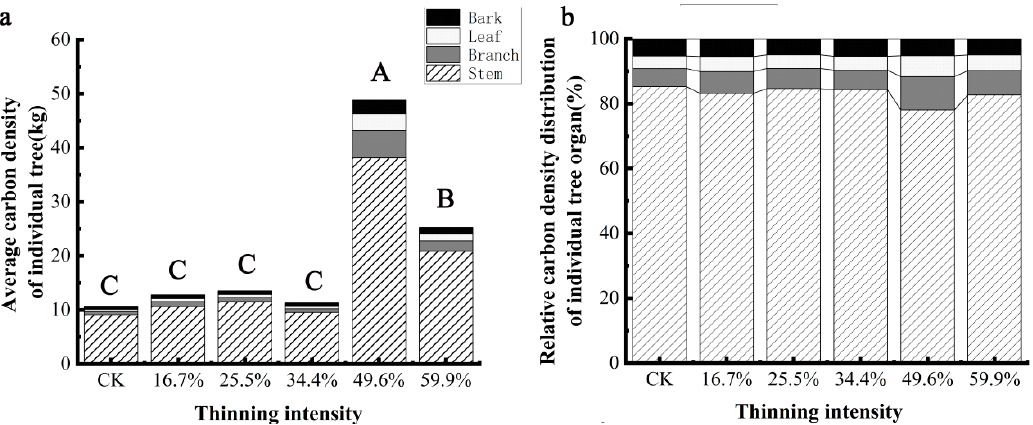
Figure 8. The average individual tree organ carbon density and its allocation of birch. Note: ( a ) is birch average carbon density of individual tree, ( b ) is birch relative carbon density distribution of individual tree organ. The different capital letters in the same graph denote a statistically significant difference at p < 0.05 of the average carbon density between thinning intensity